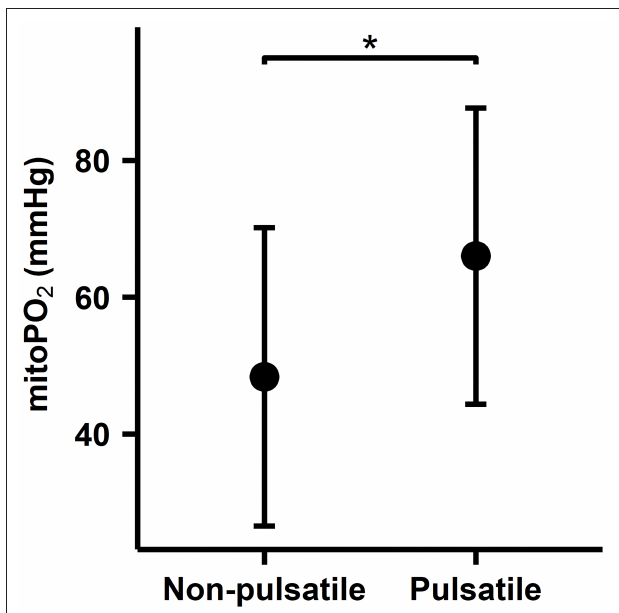
FIGURE 6 | Comparison between valve surgery aortic cross-clamp period and CABG non-aortic cross-clamp period. An average of the 20-min data window after the extracorporeal circulation has been running for 15min per patient. Mean SD plot of cutaneous mitoPO 2 . *indicates a statistically significant difference p <